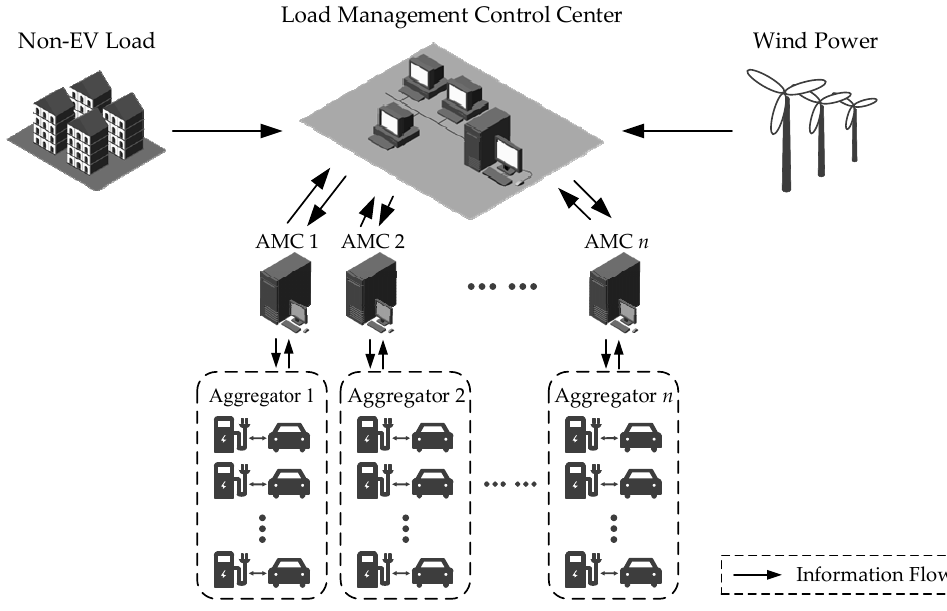
Figure 1. Schematic illustration of the real-time control framework.